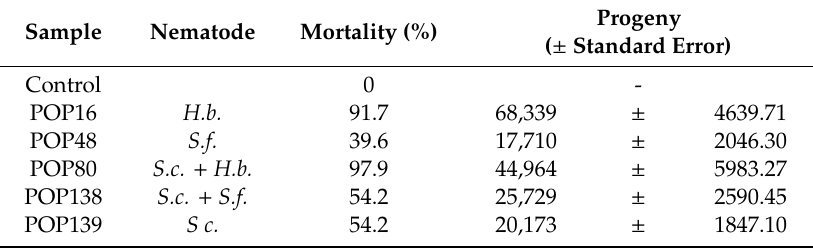
Table 3. Popillia japonica mortality caused by the five most performing entomopathogenic nematodes (EPN) isolates and their progeny in the semi-field